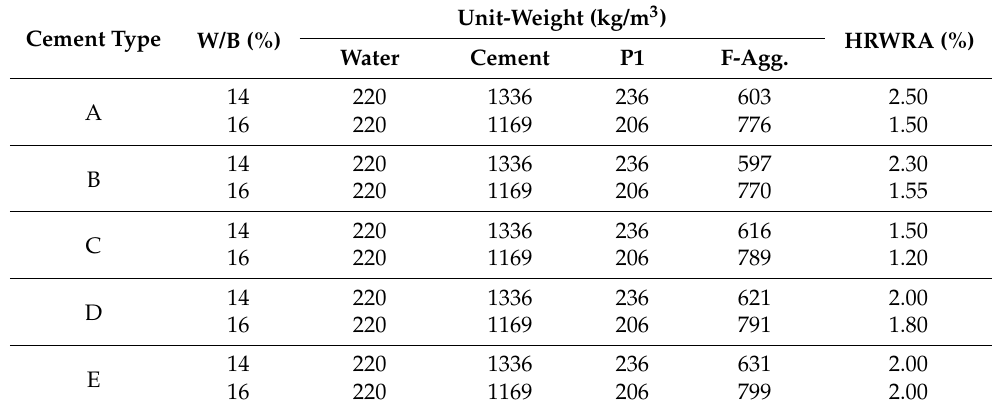
Table 3. Mixture proportions of base mortar (a test for the effect of cement type).